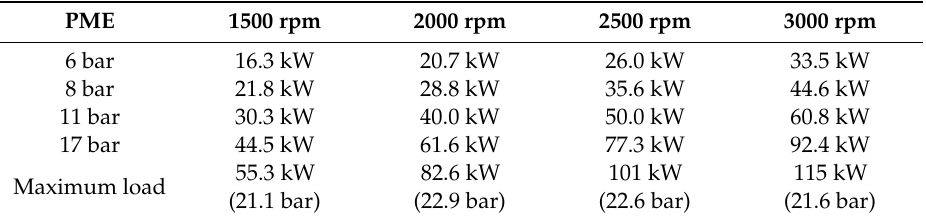
Table 1. Internal combustion engine (ICE) power in the 20 analyzed